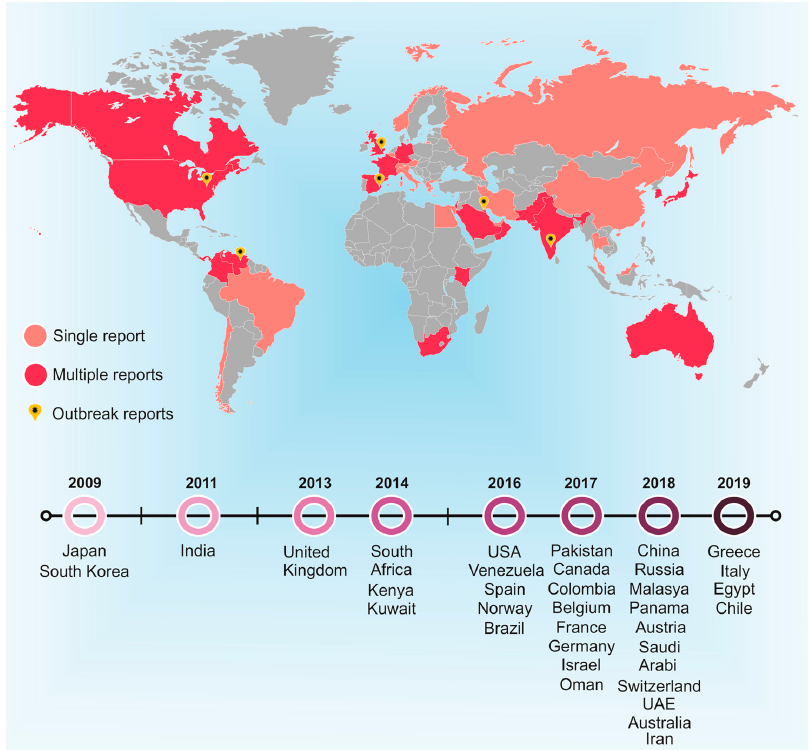
Figure 1. Global distribution of Candida auris between 2009 and 2019. Single cases are represented as ( ), whereas multiple cases are represented as ( ). ( ) Represents outbreak reports. The timeline presents the first report in each country highlighted over the years, with 2009 being the year in which the first case was reported.